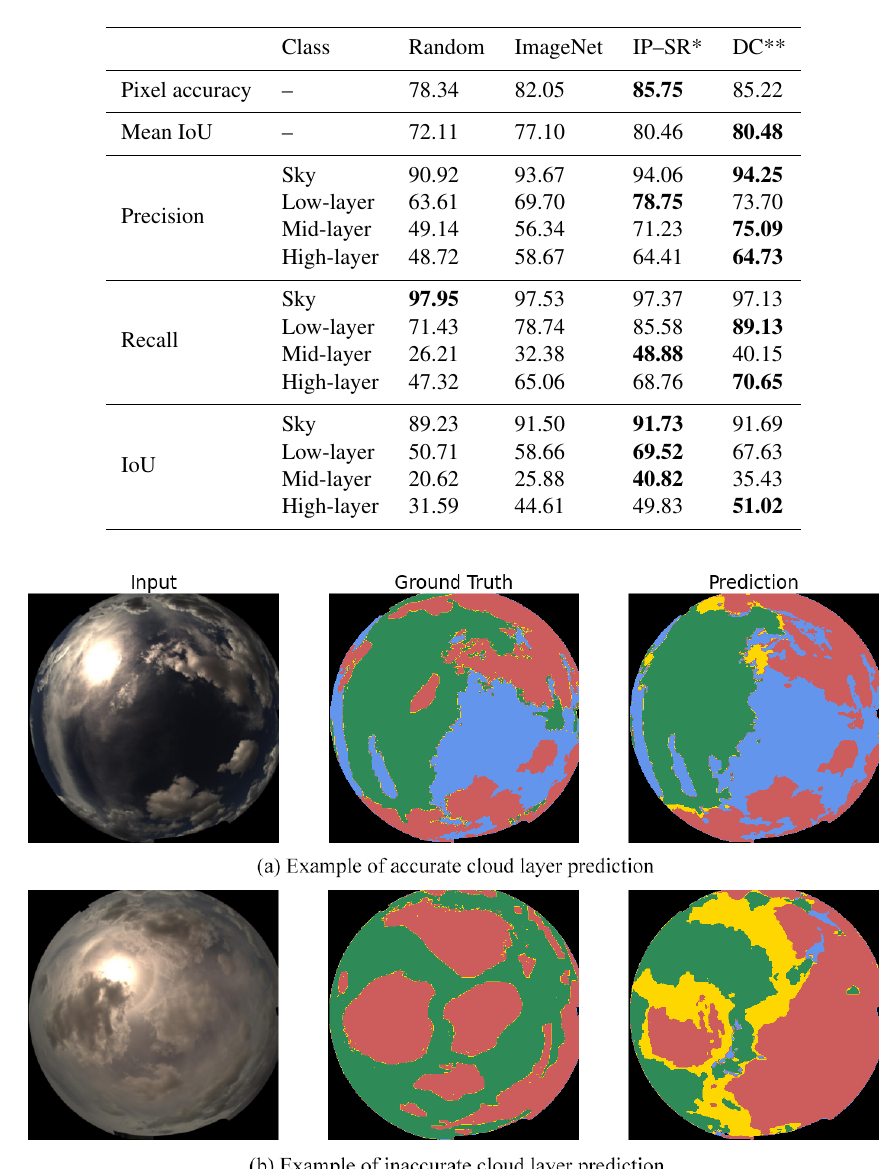
Table 3. Segmentation results comparing our self-supervised approaches with standard ImageNet or random initialization. IP–SR* and DC** refer to pretraining starting with ImageNet weights and k = 30 for the DC method. Best values are highlighted in bold.